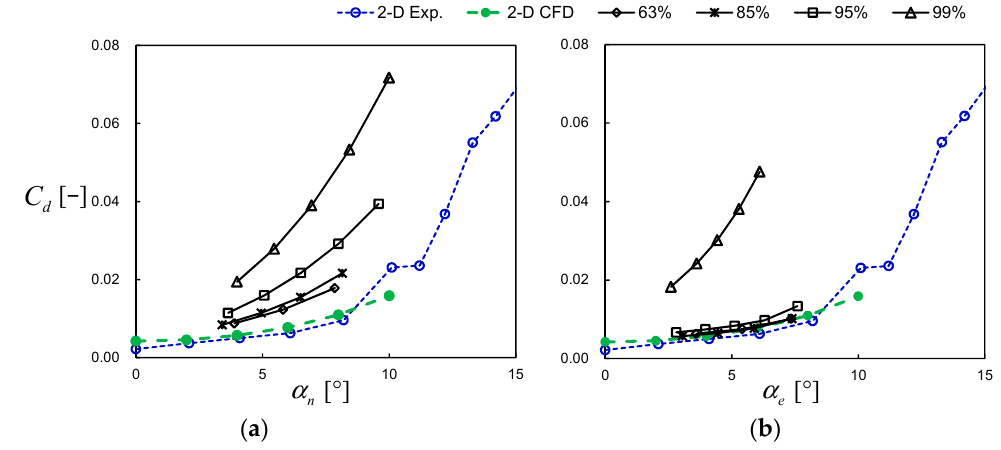
Figure 17. Drag coe ffi cient extracted through: ( a ) nominal AoA; ( b ) e ff ective Figure 17. Drag coefficient extracted through: ( a ) nominal AoA; ( b ) effective AoA.